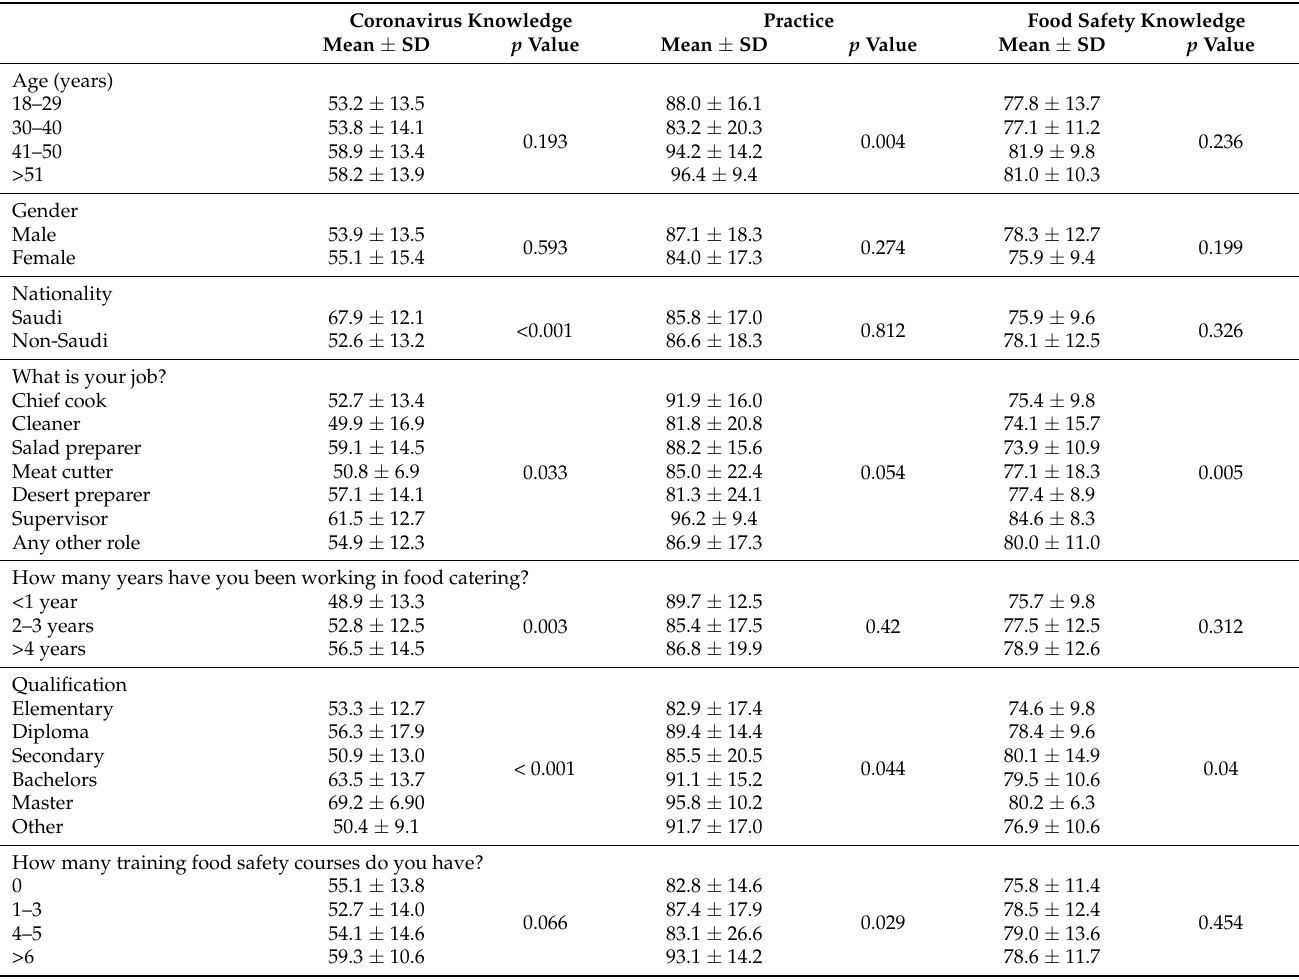
Table 6. Respondents’ food safety knowledge, attitudes, and practices by their sociodemographic and employment